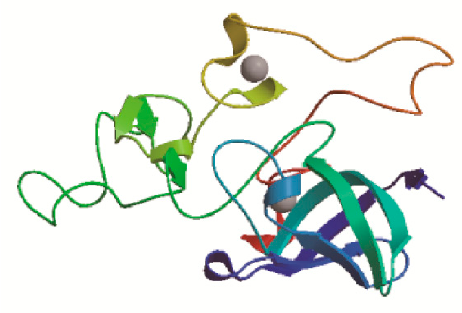
Figure 3. Tertiary structure prediction of the BcCSP3 protein. Random coil, extended strand and beta turn make up most of the main